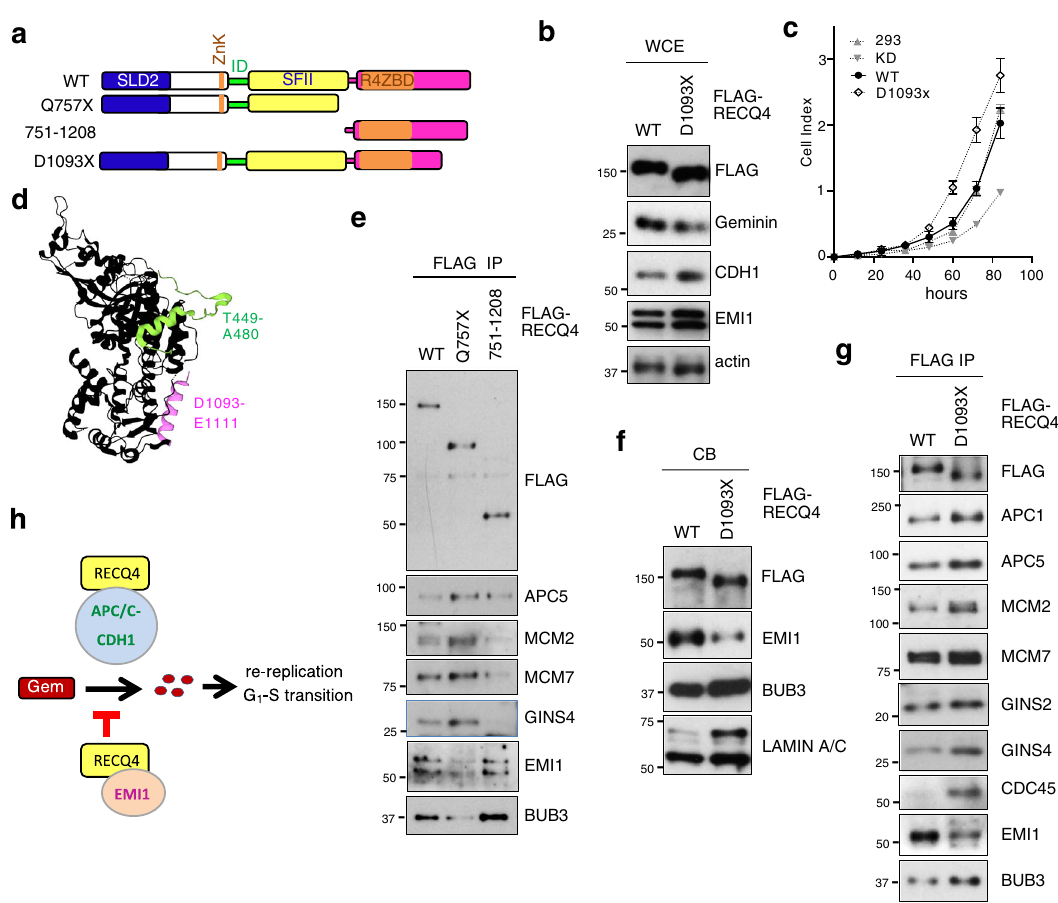
Fig. 7 | RECQ4 C-terminal interaction with EMI1 is inversely correlated with RECQ4N-terminalinteractionwithAPC/C.a AschematicdiagramofRECQ4wild type (WT), Q757X mutant, C-terminal fragment (751 – 1028), and D1093X mutant. b Representative western blot analysis of the indicated proteins in whole-cell extracts (WCE) prepared from RECQ4 WT and D1093X expressing cells. Actin was used asaloading control. c Representative real-timecellgrowthassaysto measure cell growth rate of HEK293 or RECQ4 knockdown (KD) cells with or without stable expression of FLAG-RECQ4 WT or D1093X mutant. n =4 (biologically independent samples), except HEK293 control cells, where n =3 (biological independent sam- ples). Data are presented as mean values ± SD. d Structure of RECQ4 427-1116 (5LST) drawnusingRProteinDataBank.TheresiduesvisibleinthestructurebetweenT449